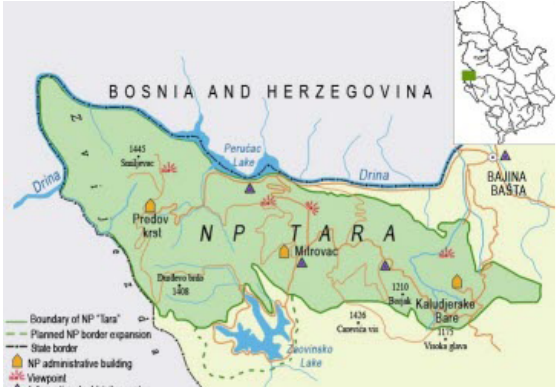
Figure 1. Map and position of the Na- tional Park Tara in Western